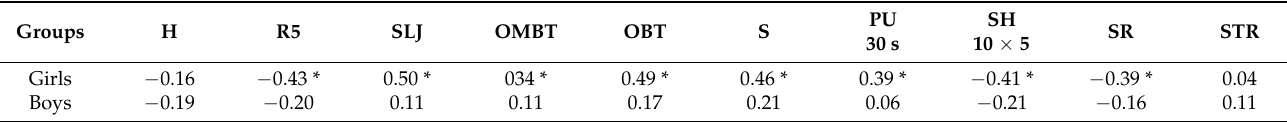
Table 4. Spearman correlation coefficients between physical variables of selected field tests and the current competitive performance of the same sex as a single group ( n =